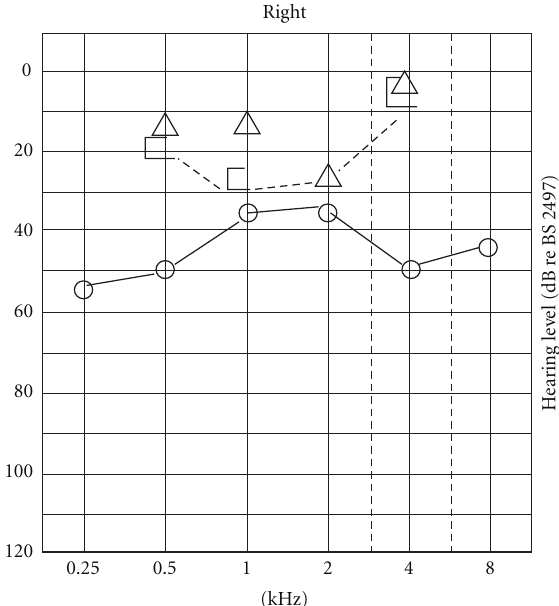
Figure 2: Pure-tone audiogram prior to revision surgery.